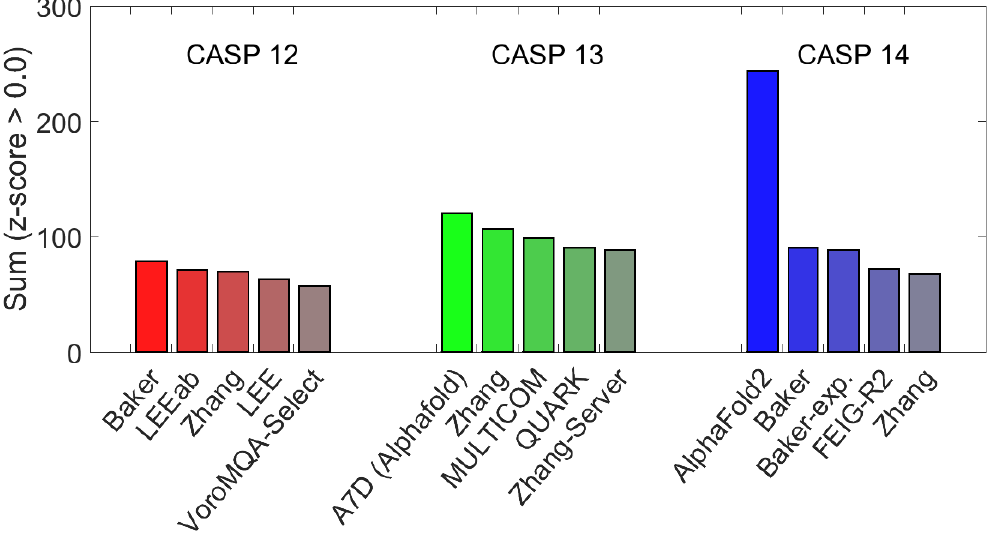
Figure 3. CASP 12-14 top 5 competitors per year (x-axis). The performance for each competition was based primarily on the summation of positive Zscores (y-axis) with respect to GDT_TS for each of the proposed structure prediction models. The accuracy metric, GDT_TS, is a multiscale indicator for the proximity of C α atoms in a model to those in the corresponding experimental